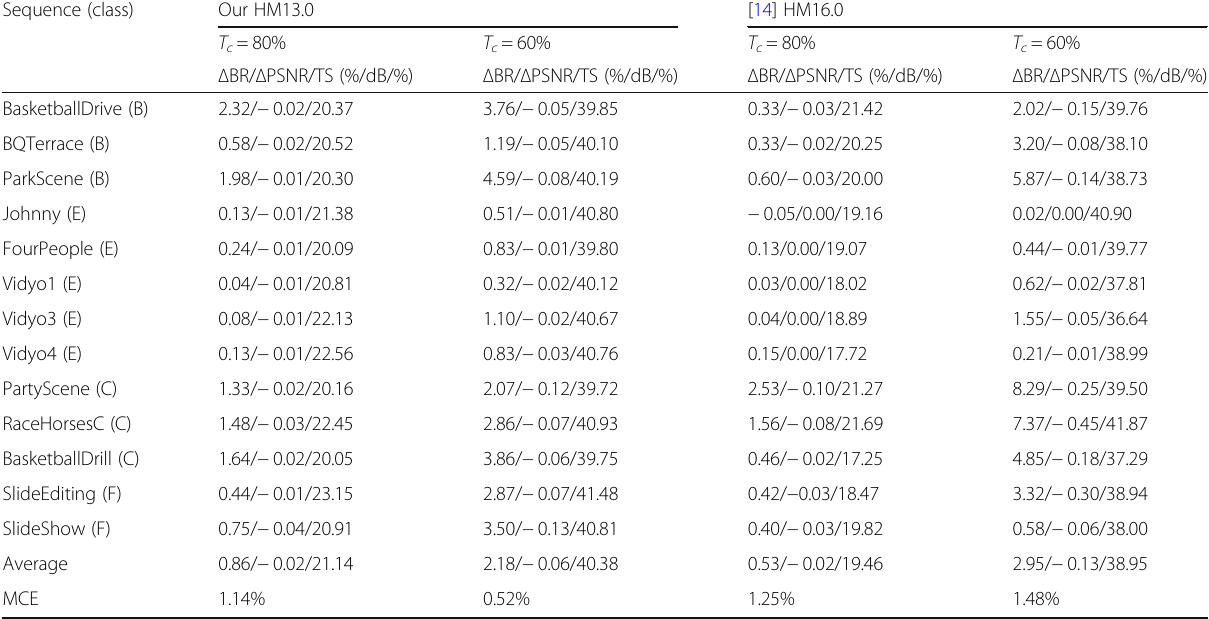
Table 5 Performance comparison between the proposed algorithm and [14]